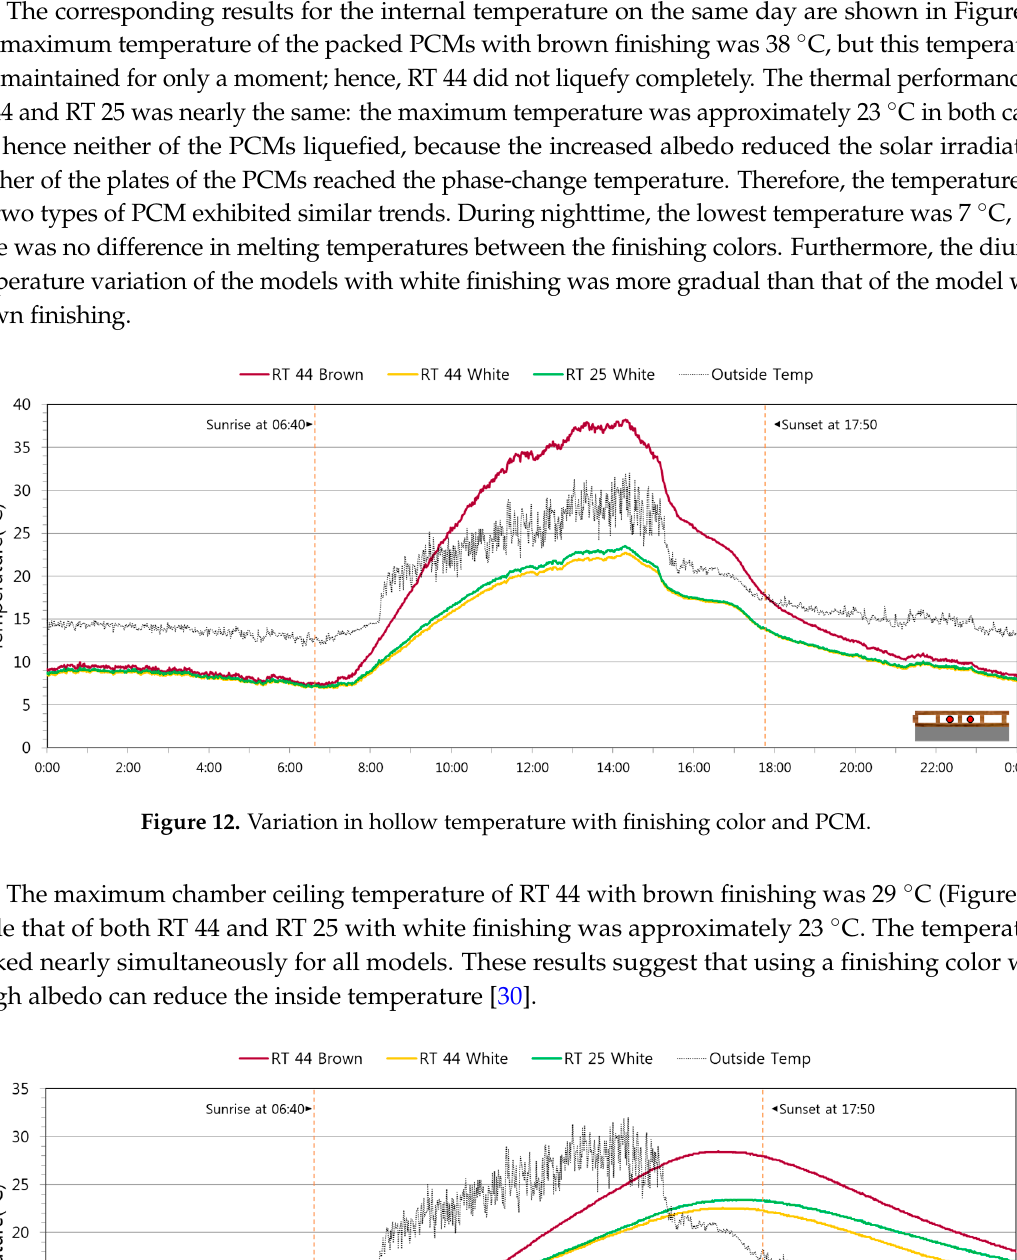
Figure 11. Variation in outer surface temperature with finishing color and PCM.